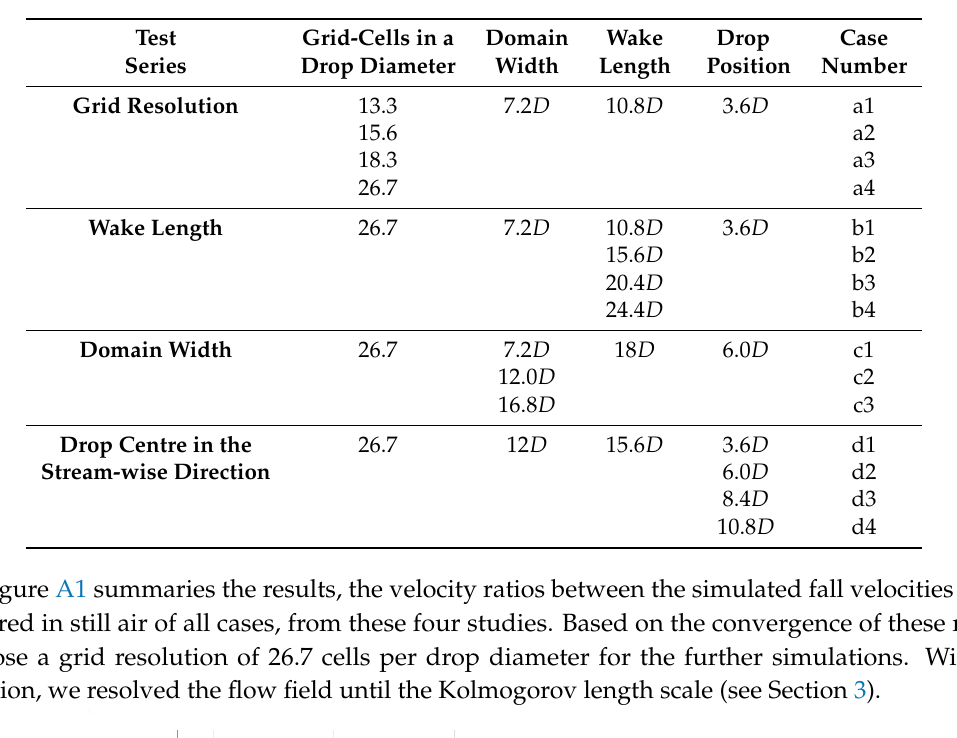
Table A1. Setup for the studies of the grid resolution, the size of the simulation domain and the position of water drop in the main flow direction.